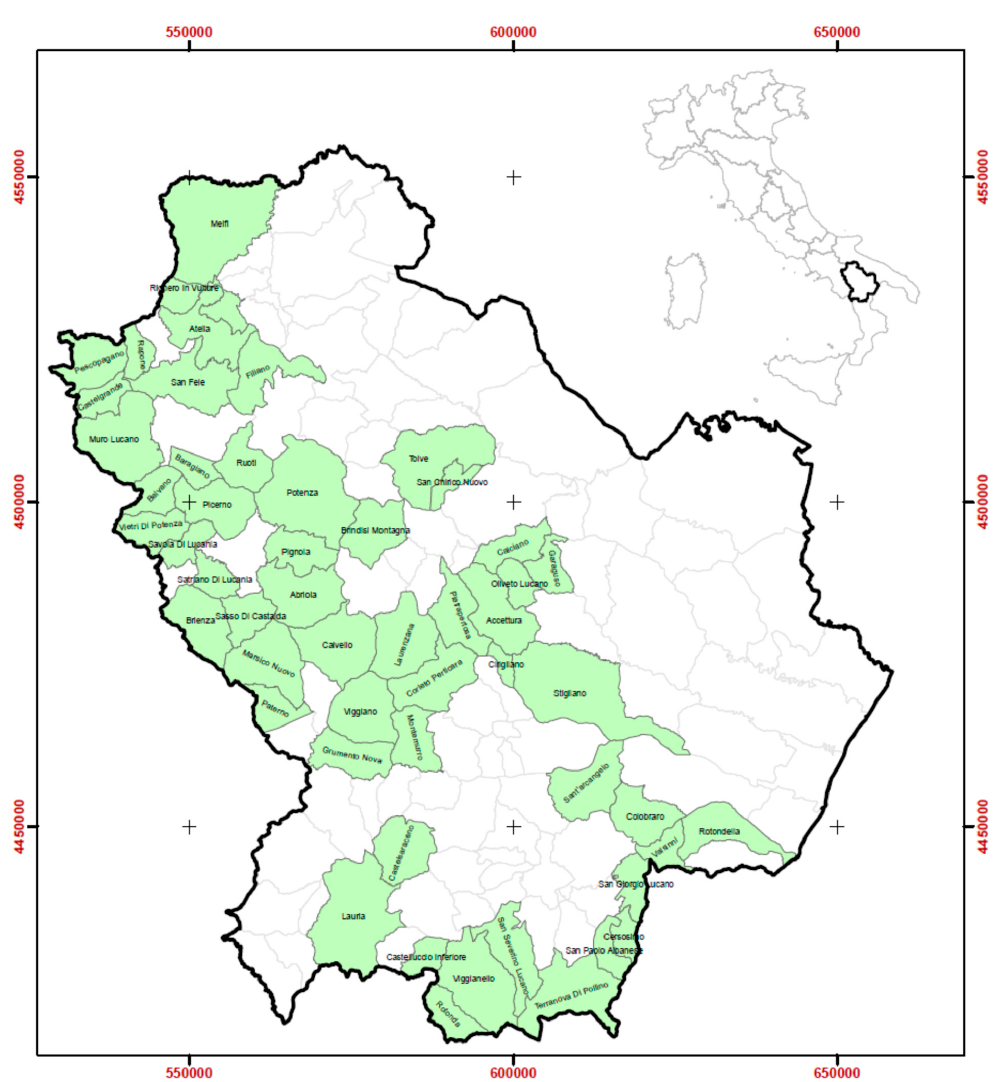
Figure 1. Study area: municipalities of the Basilicata region in which forest management plans (FMPs) are still in force.